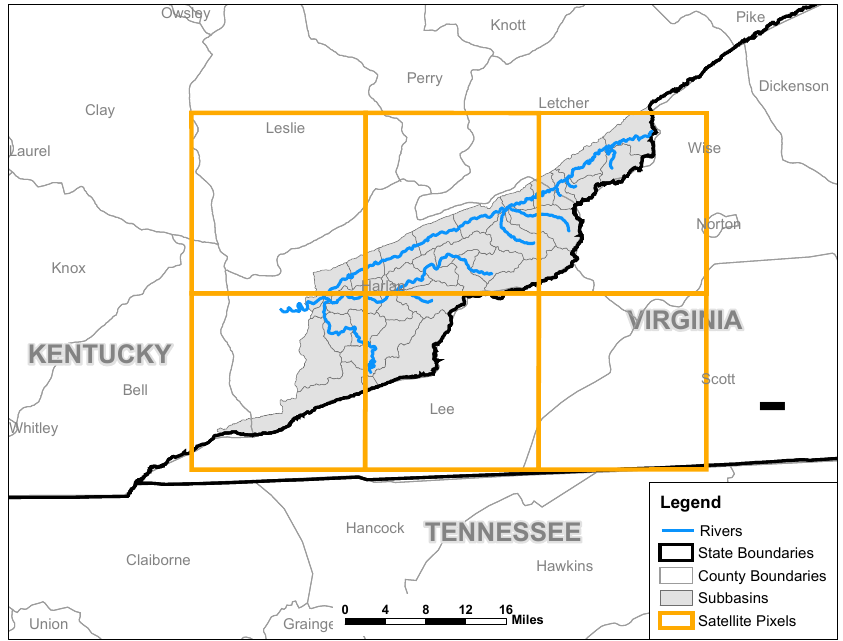
Figure 2. River network of the Upper Cumberland basin. Gridboxes in yellow represent the location of 3B41RT satellite rainfall pixels over the basin.